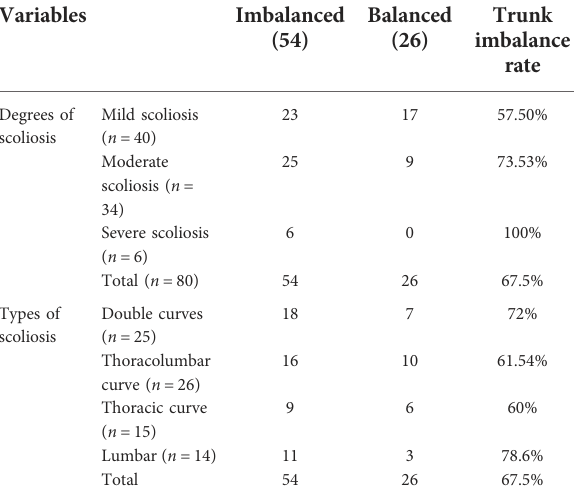
TABLE 2 Data of the coronal trunk balance and imbalance group (median and interquartile Balanced Trunk (54) (26) imbalance rate